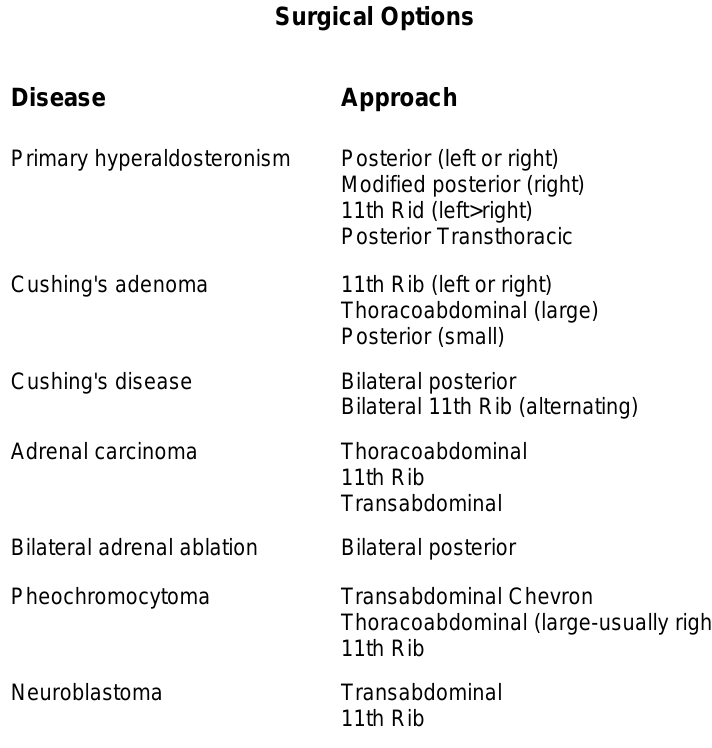
Surgical Options